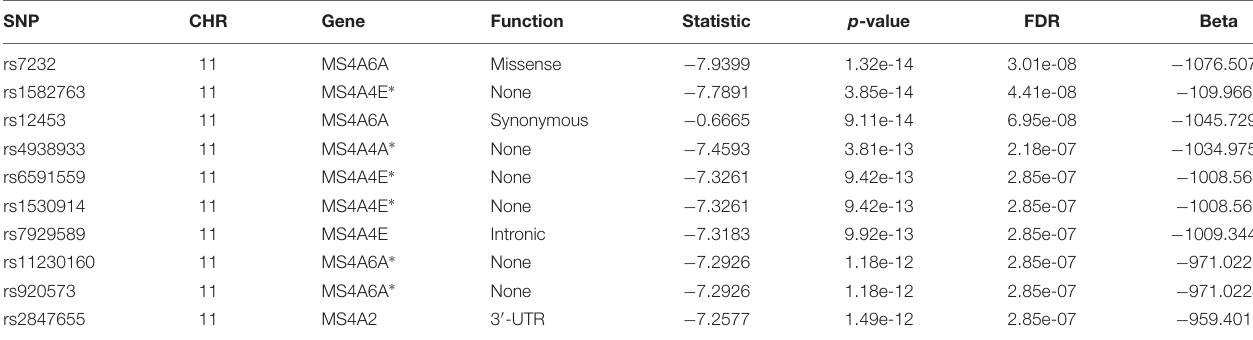
TABLE 2 | Top 10 most significant SNPs identified by the QTL analysis for CSF